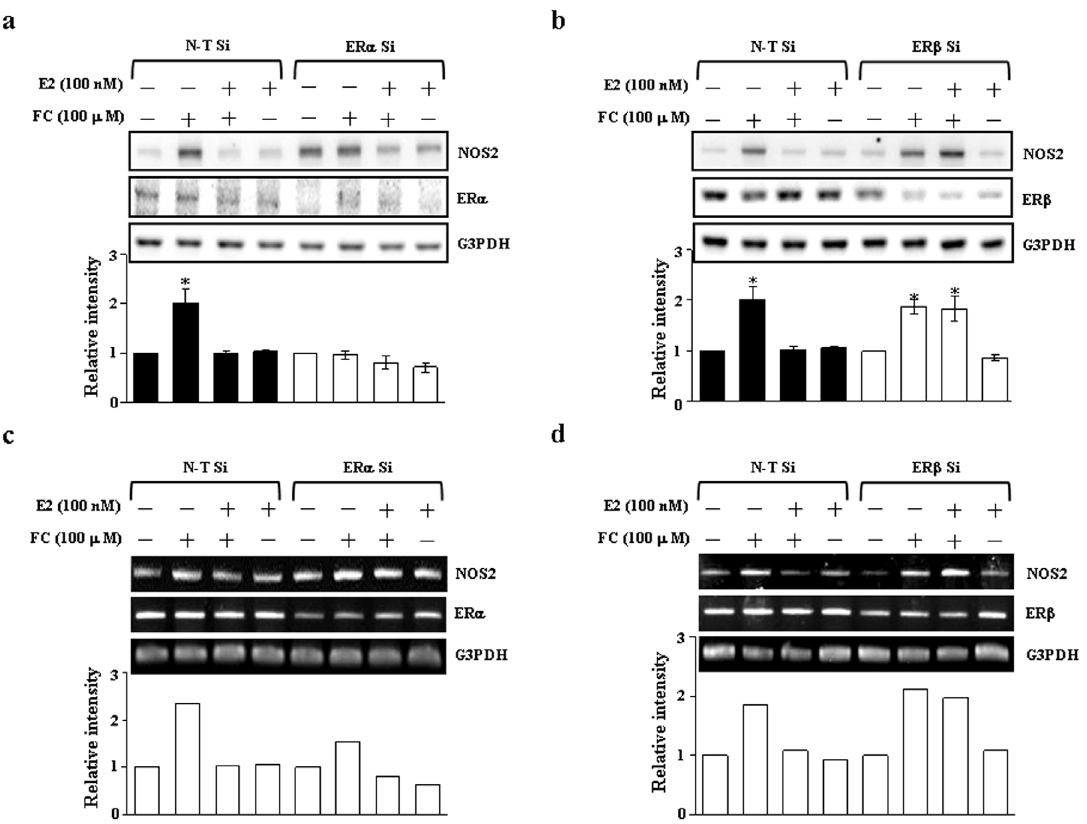
Figure 5. Involvement of the ER subtype on the E2-mediated inhibition of the FC-induced NOS2 up-regulation. (a) Pre-transfection of CEC with ER a siRNA did not significantly affect the E2-mediated inhibition on the FC-induced increases of the levels of NOS2 protein. (b) Pre- transfection of CEC with ER b siRNA abolished the E2-mediated inhibition on the FC-induced increases of the levels of NOS2 protein. Top panel: representative results of NOS2 and G3PDH protein levels determined by Western blot analysis. Membrane was probed with anti-G3PDH antibody to verify equivalent loading. Bottom panel: quantitative results of NOS2 protein levels, which were adjusted with G3PDH protein level and expressed as fold-induction of its own control. Values represent the means 6 s.e.mean. (n=3). * P , 0.05, different from cells treated with FC. (c) Pre-transfection of CEC with ER a siRNA did not significantly affect the E2-mediated inhibition on the FC-induced increases of the levels of NOS2 mRNA. (d) Pre- transfection of CEC with ER b siRNA abolished the E2-mediated inhibition on the FC-induced increases of the levels of NOS2 mRNA. The levels of mRNA were detected by RT-PCR (top panel) or real-time quantitative PCR (bottom panel). ER, estrogen receptor; N-T Si, non-target siRNA; Si, small interfering RNA.